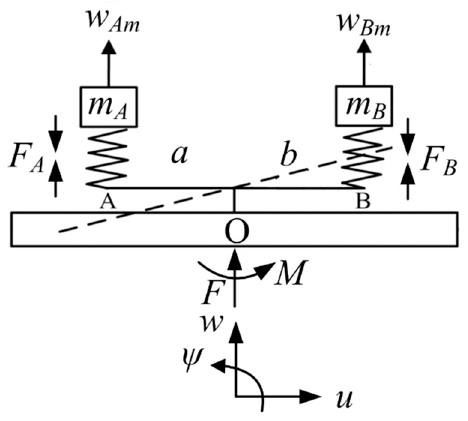
Figure 3. Free body diagram of a single uncoupled force-moment type resonator.